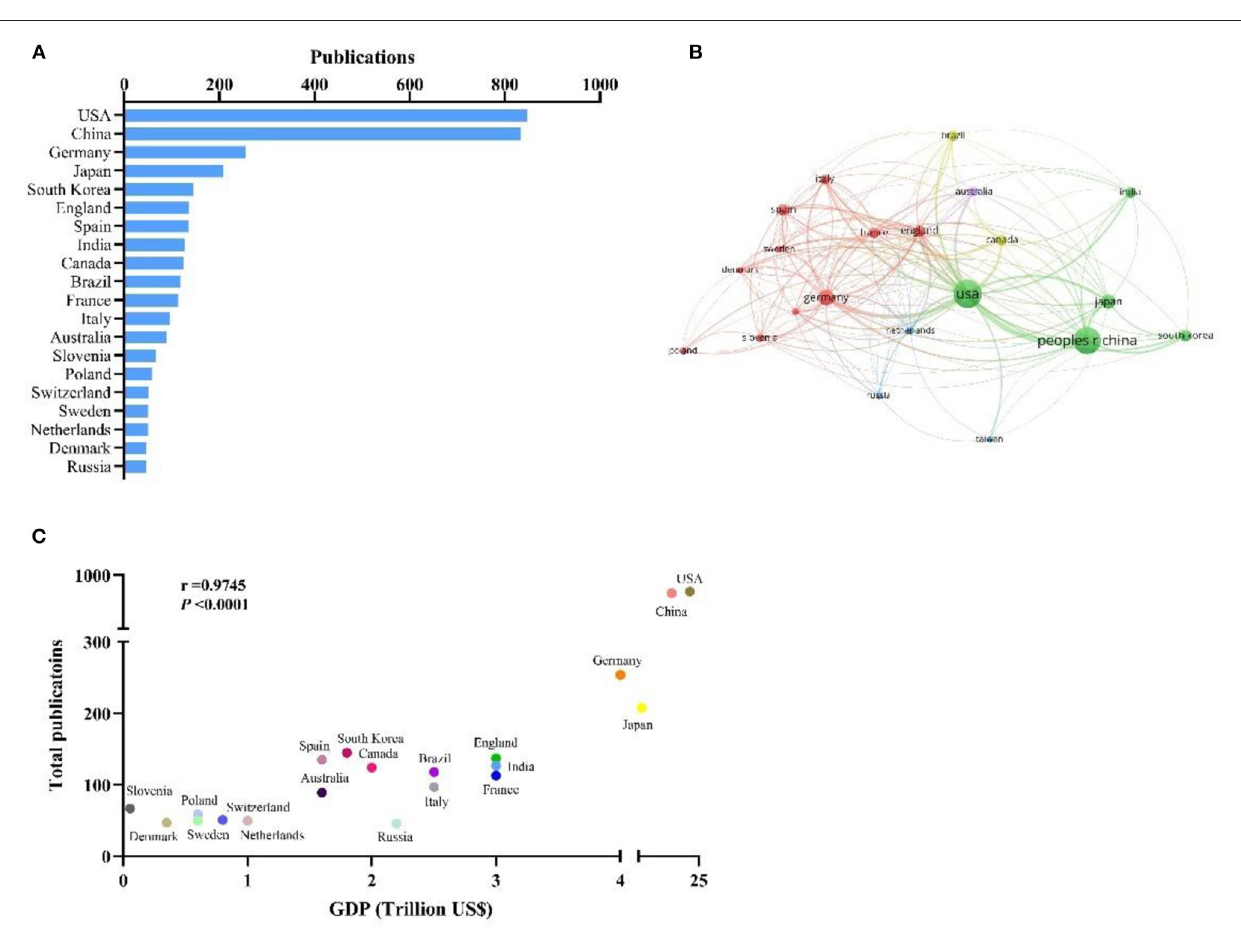
( n = 137), Spain (135), India ( n = 127), Canada ( n = 124), Brazil ( n = 118), and France ( n = 113). The network map (T = 46) shows the collaboration between these top countries/regions